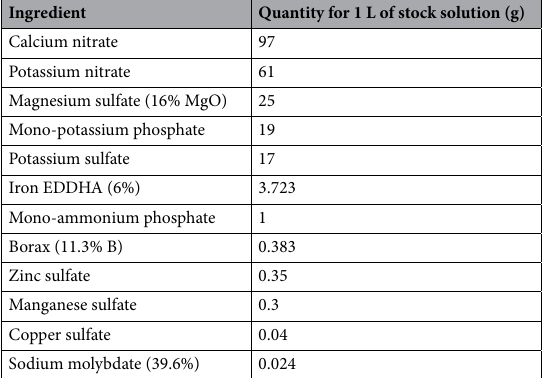
Table 2. Stock solutions’ ingredients employed in the present study. From each stock solution, 10 mL was added to prepare 1 L of nutrient